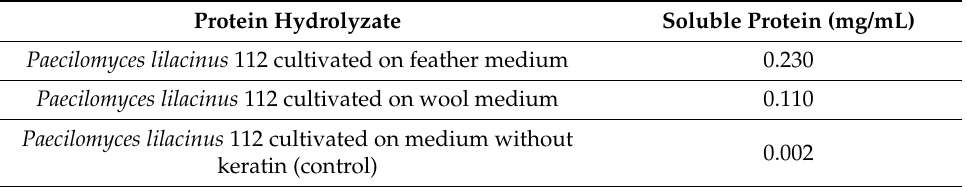
Table 2. Content of soluble protein in fungal hydrolyzates.